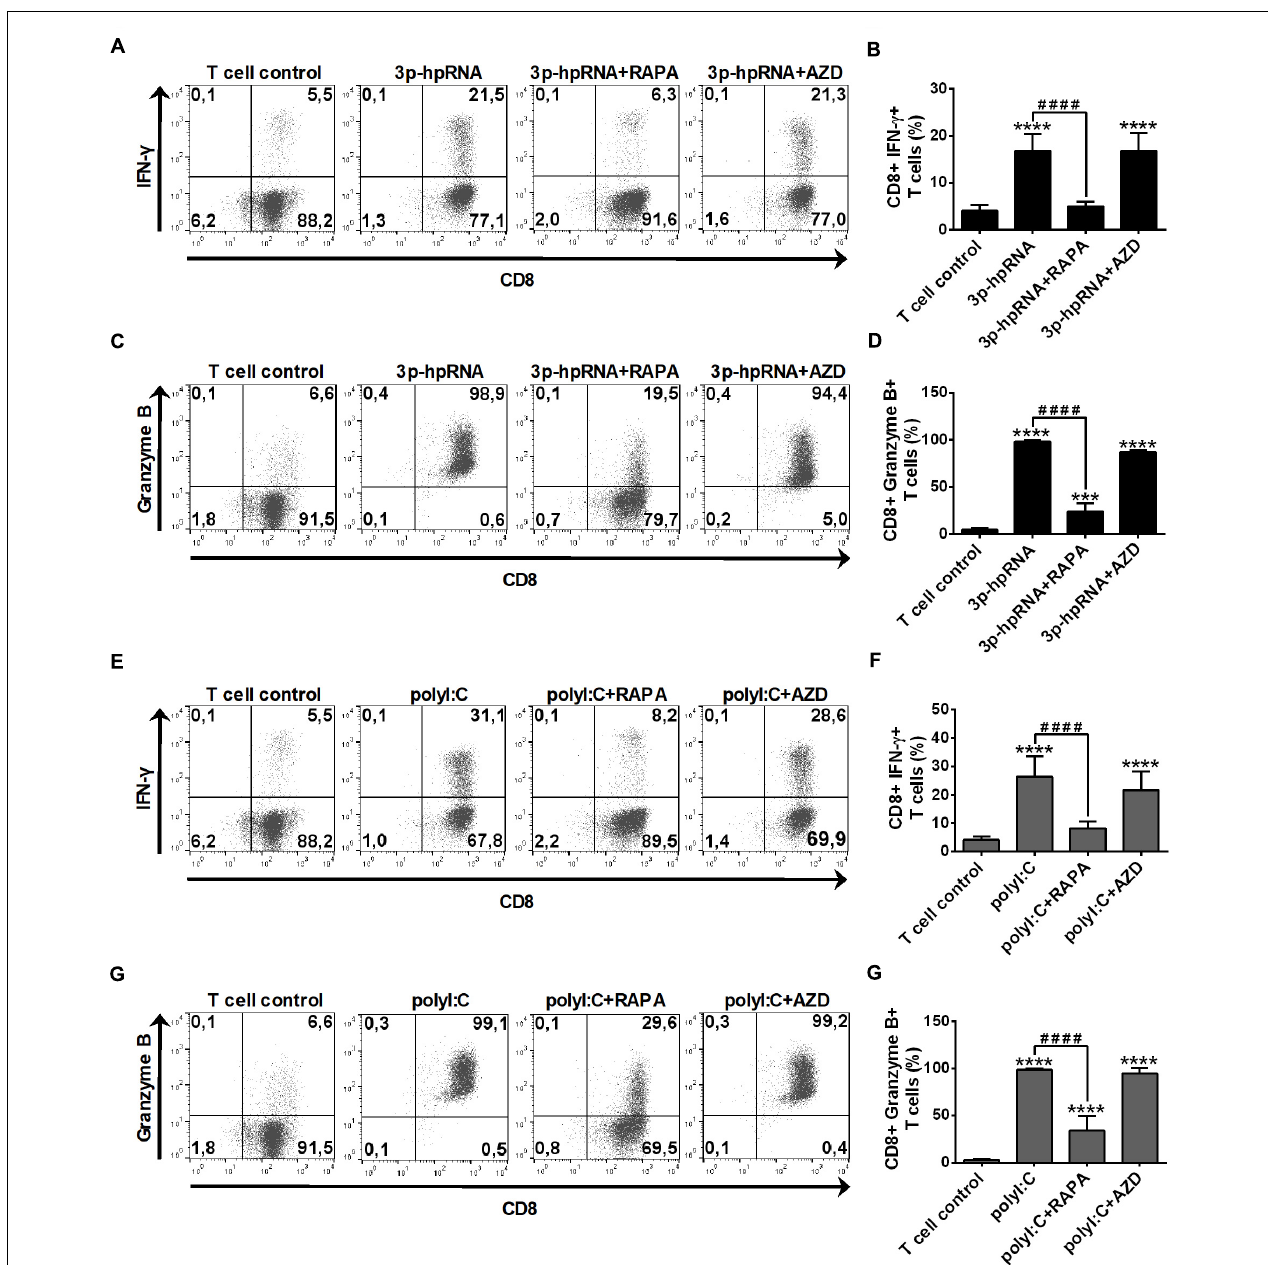
FIGURE 10 | Rapamycin but not AZD8055 decreased the T cell activating capacity of RLR-activated moDCs. Naïve CD8 + T cells were co-cultured with allogeneic moDCs pre-treated with the indicated reagents. After 6 days of co-cultivation T cells were stimulated with phorbol myristate acetate (0.1 µ g/ml) and ionomycin (1 µ g/ml) in the presence of monensin for 5 h. IFN-y and Granzyme B production of CD8 + T cells was measured by intracellular cytokine staining using flow cytometry. (A,C,E,G) Data from one representative experiment are shown. Numbers in quadrants indicate percent cells in each. In A and E as well as in C and G T cell controls are the same, since representative dot plots originate from the same set of experiment from one single donor. (B,D,F,H) Bar graphs represent the mean ± SD of 6 independent experiments. *** p < 0.01, **** p < 0.0001 vs. control; #### p < 0.0001. AZD: AZD8055, RAPA: